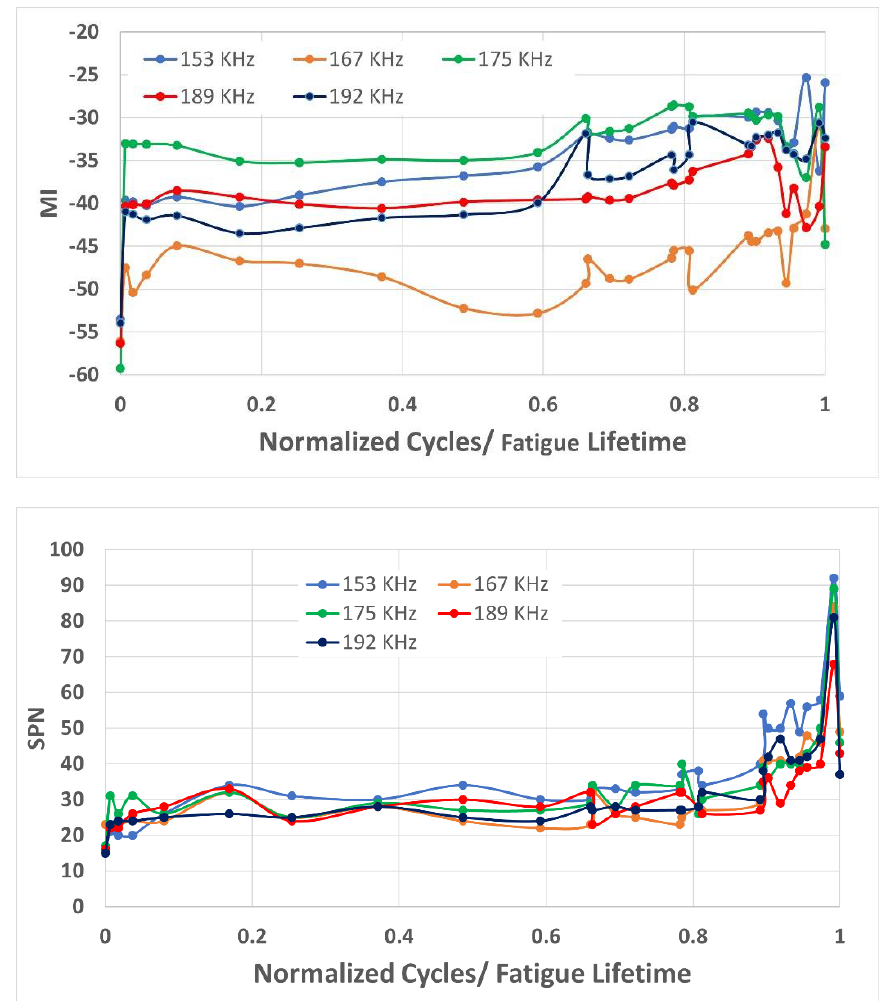
Figure 10. Variations of parameter MI ( upper ) and SPN ( lower ) for Sample #4 for different probe frequencies.